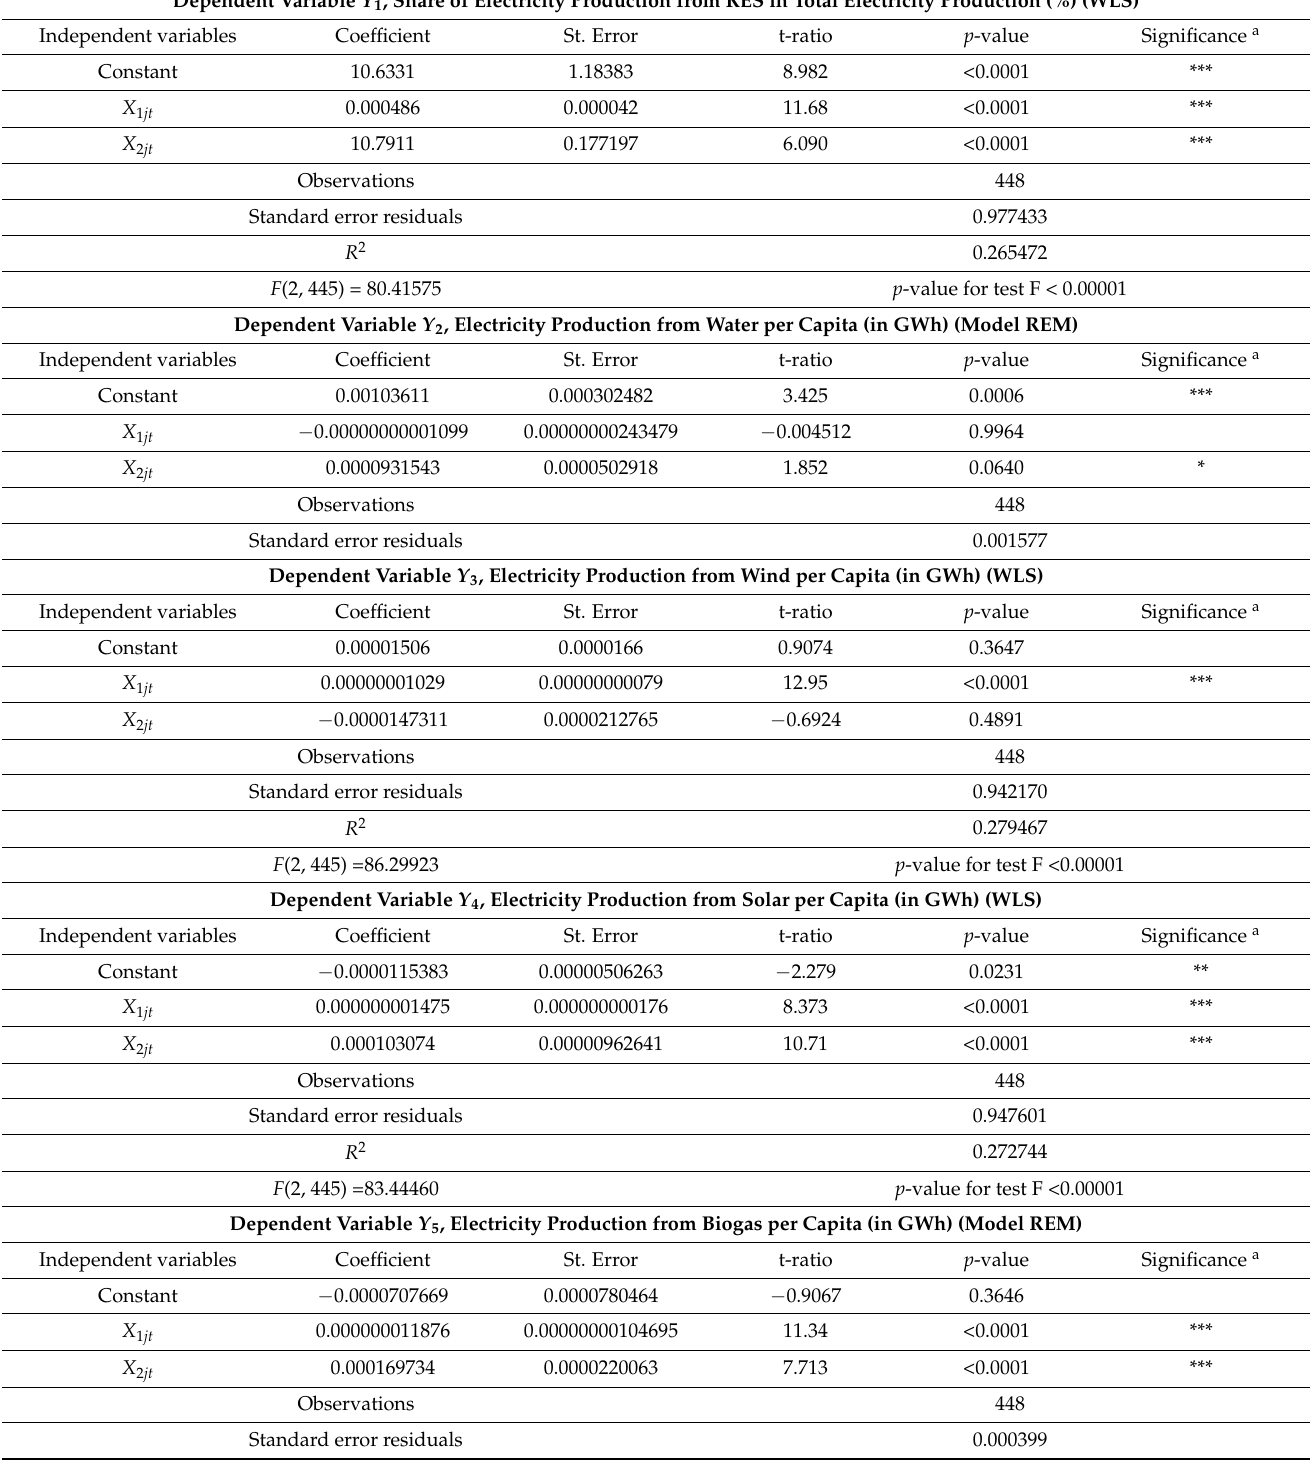
Table 6. Results of model